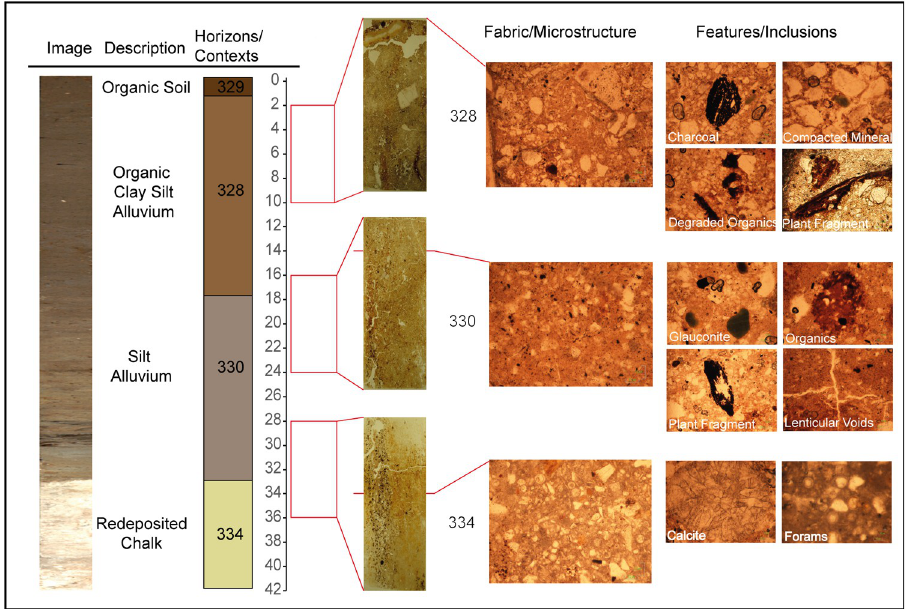
Fig 3. Micromorphological analysis of sediment contexts 328, 330 and 334 in the analysed sequence. Photos of each slide are shown alongside images of general fabric and microstructure characteristics alongside key organic and inorganic features and inclusions within the sediment. (All images are in plane polarised light at 10x magnification).